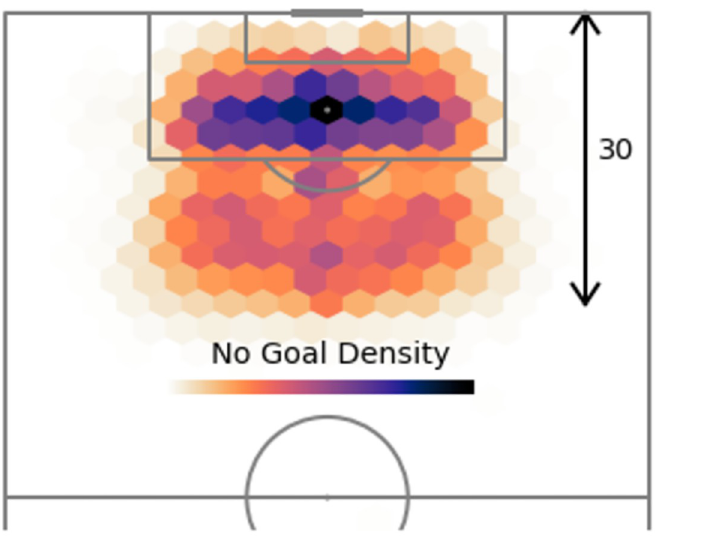
Fig 3. Heatmap of the where shots are taken from that do no result in a goal.